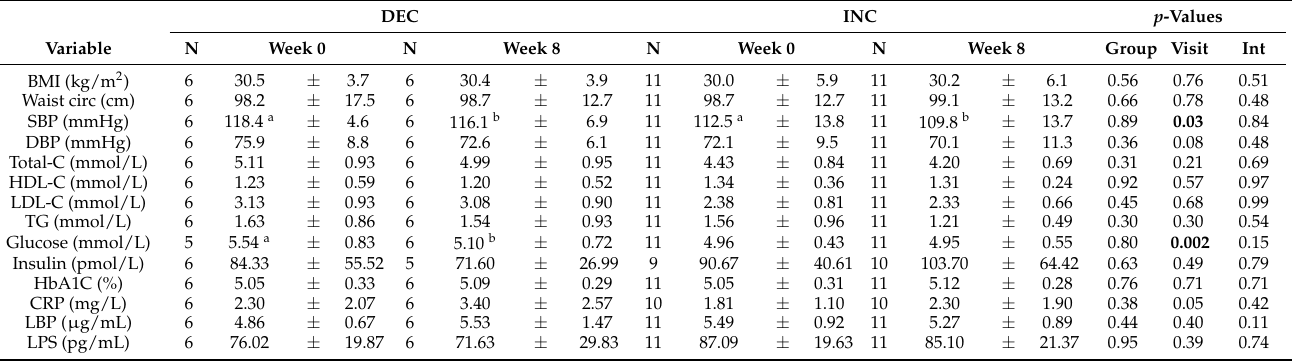
Table 2. Longitudinal changes between week 0 and week 8 in clinical characteristics of participants according to TMAO